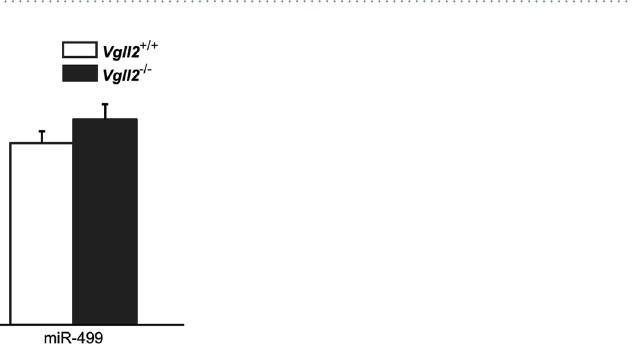
Figure 5. Physical interaction analysis between endogenous Vgll2 and TEAD1 in skeletal muscles at the neonatal stage. ( a ) Immunoprecipitation was conducted with the anti-Vgll2 antibody followed by Western blot analysis to detect TEAD1, TEAD4 and Vgll2 in GPS muscle extracts from Vgll2 + / + and Vgll2 − / − mice at P7. ( b ) Immunoprecipitation was conducted with an anti-TEAD1 antibody followed by Western blot analysis to detect Vgll2 and TEAD1 in P7 GPS muscle extracts. ( c ) Immunoprecipitation was conducted with an anti- TEAD4 antibody followed by Western blot analysis to detect Vgll2 and TEAD4 in P7 GPS muscle extracts. Control samples were GPS muscle lysates incubated without anti-Vgll2 or -TEAD1 antibody (no-Ab). Uncropped original images are shown in Supplementary information.